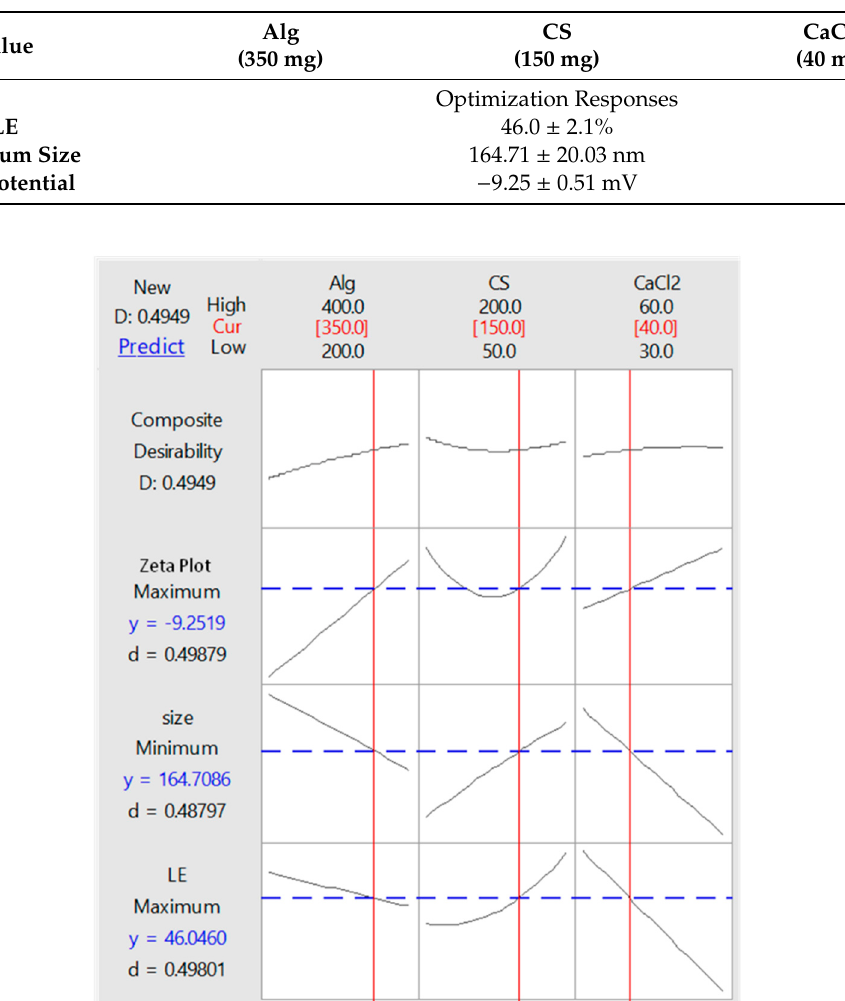
Figure 9. The optimization plot for metronidazole (MET), chitosan (CS) and alginate (Alg) nanoparticles (NP) (MET-CS-AlgNPs) nanocomposites.